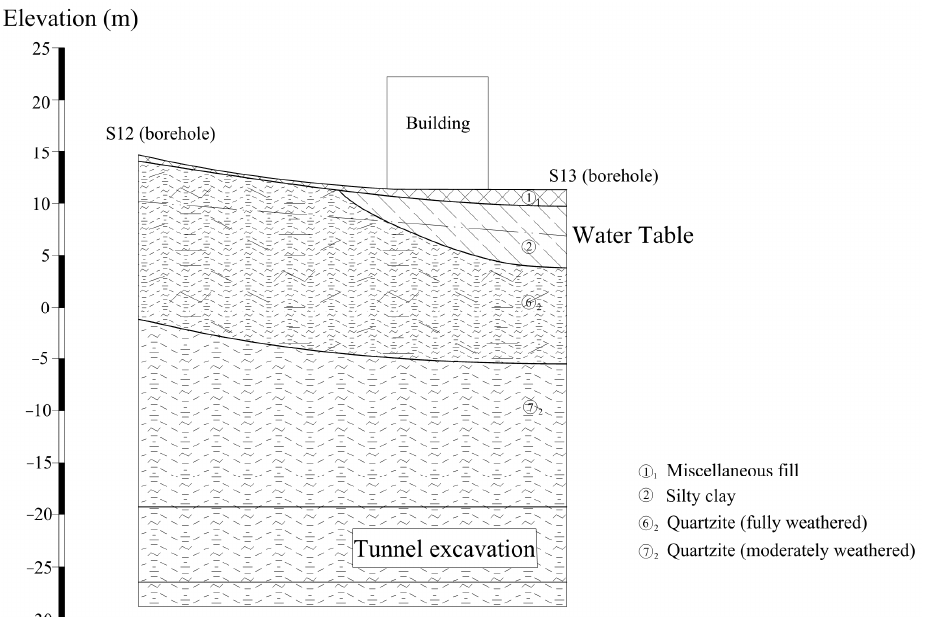
Figure 5. Geological profile of the tunnel and location of the building .